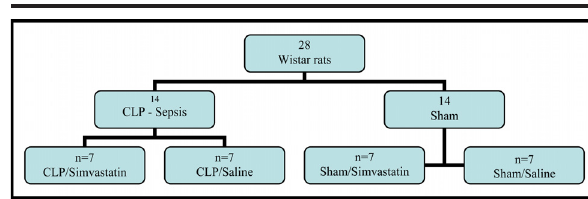
FIGURE 1 - Experimental design: 14 rats were divided into group CLP/sepsis treated with simvastatin (CLP/Simvastatin n=7) and with saline (CLP/ saline n=7). In group sham (n=14), rats were treated with simvastatin (Sham/Simvastatin n=7) and with saline (Sham/Saline